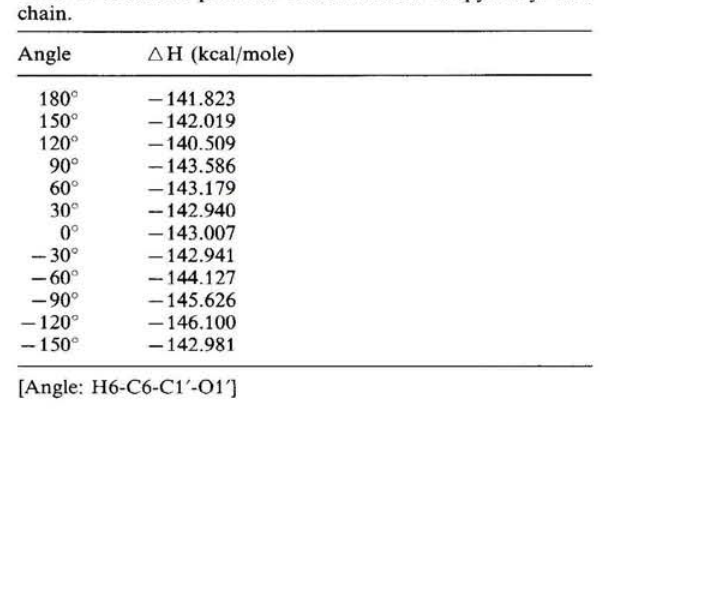
Table 1. Reaction path for conformations of pyruvoyl side